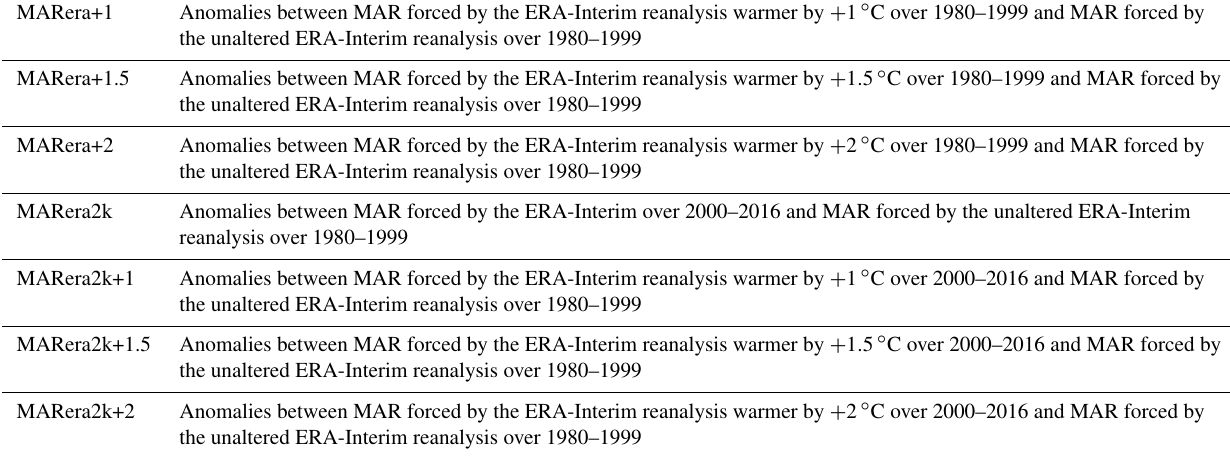
Table A1. Abbreviation description of reanalysis sensitivity experiments.